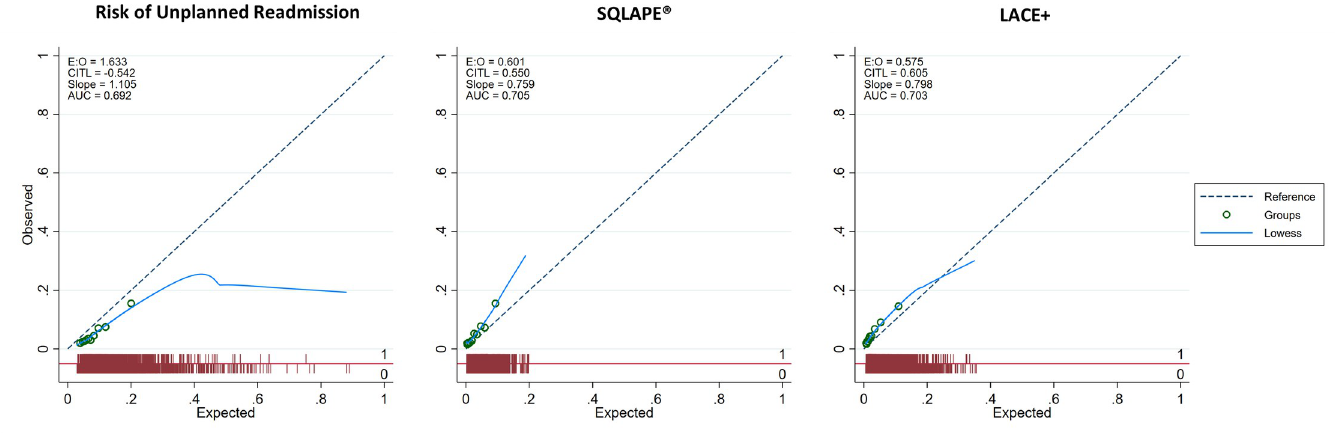
Fig 2. Calibration plots Cohort A. (A) Abbreviations: AUC–Area under the curve; CITL–Calibration-in-the-large; E:O–Expected: Observed. (B) Notification: Associated 95% CI were too narrow to be clearly displayed.